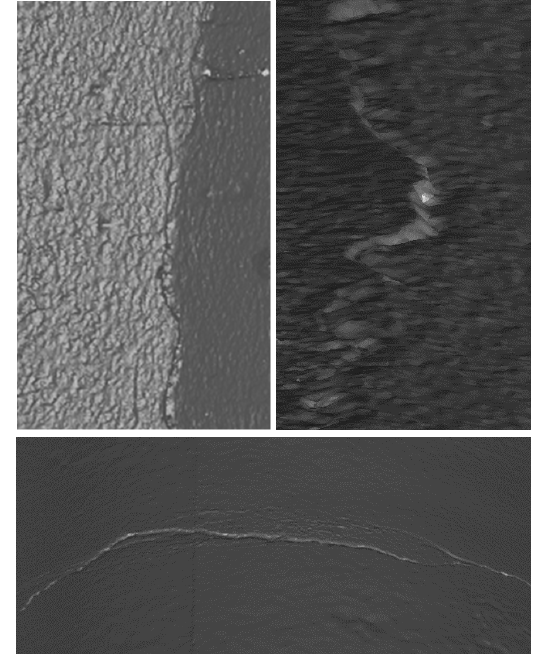
Figure 5. High fidelity 3D models of detected cracks.